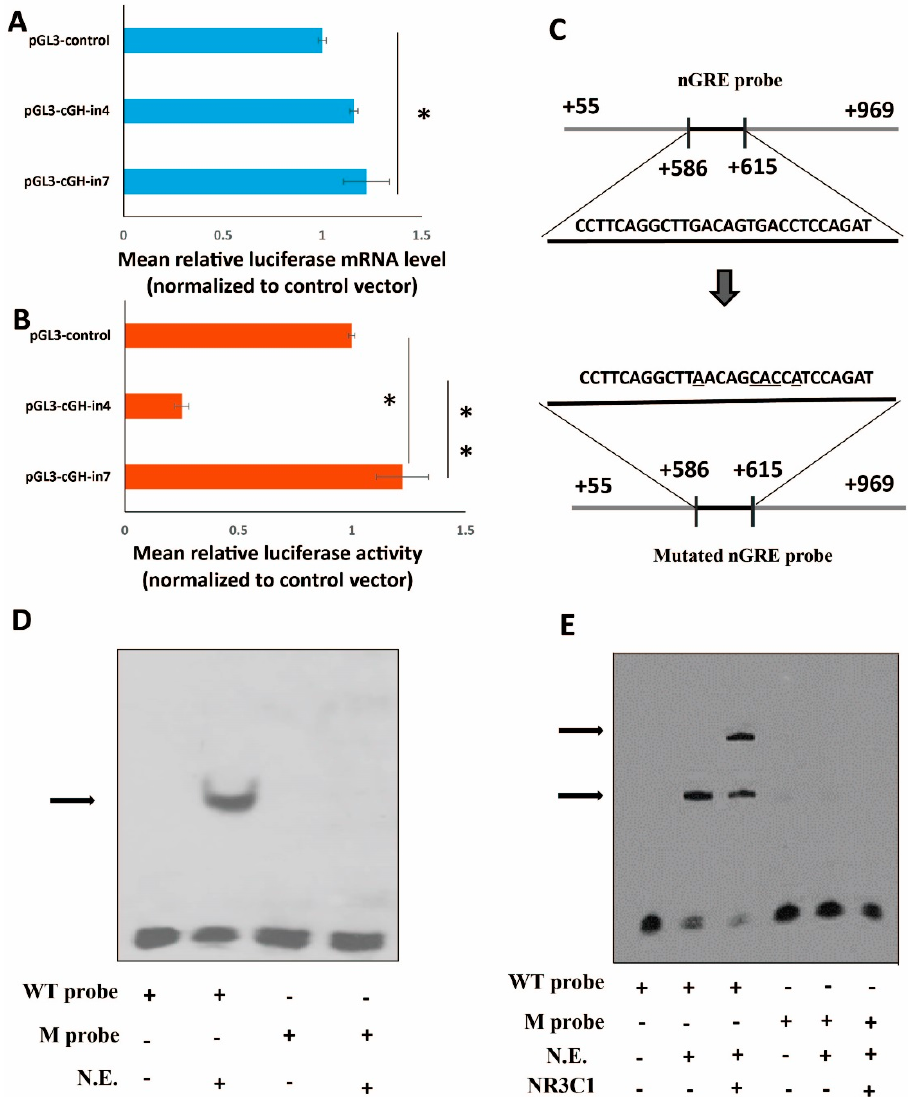
Figure 4. Role of the intronic negative glucocorticoid response element (nGRE) in reporter gene expression in GH4-C1. ( A ) The mean relative luciferase mRNA transfected with the plasmid pGL3-cGH-in4 and pGL3-cGH-in7; ( B ) the mean relative luciferase activity transfected with the plasmid pGL3-cGH-in4 and pGL3-cGH-in7. Asterisks indicate a significant difference when comparing the two indicated groups, * means p < 0.05, ** means p < 0.01; ( C ) A diagrammatic representation of the nGRE probe and mutated probe, the underlined sequences showed the mutant sequences in the mutated probe; ( D ) A representative image of nuclear protein extracts from GH4-C1 cells incubated with the wild-type (WT) nGRE probe or a mutated (M) nGRE probe ( n = 3 separate experiments), the arrow showed the lower-shifted band; ( E ) GR from GH4C1 cells was tested for binding to the nGRE probe. Electrophoretic mobility shift assay (EMSA) gel was transferred to a polyvinylidene difluoride membrane, which was detected by NR3C1 antibody. The arrows showed the lower-shifted bands. Blots represent results from three replicate experiments.